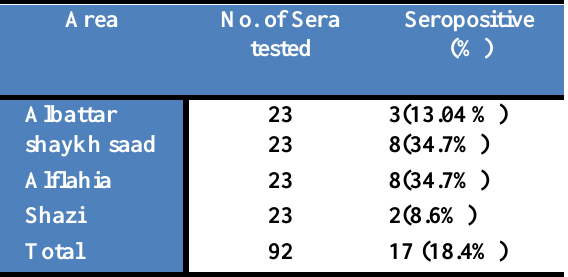
Table, 1: Percentages of positive ELIZA test for T. gondii in horses sera according to residence areas.